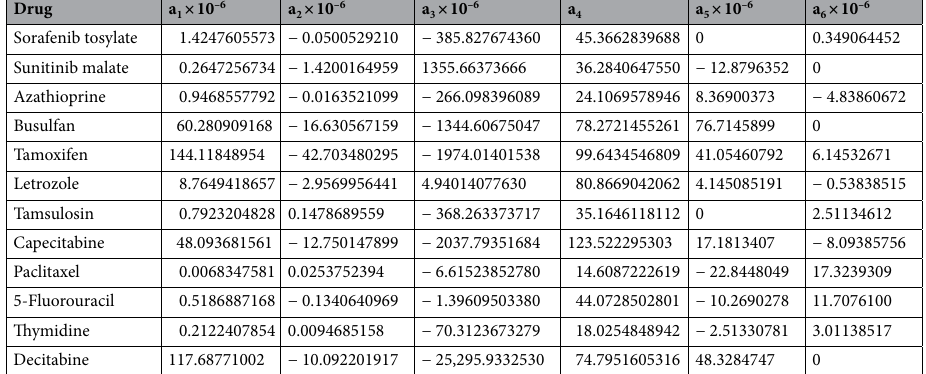
Table 3. Adjusted coefficients of the proposed correlation for estimating the solubility of anti-cancer drugs in supercritical CO 2